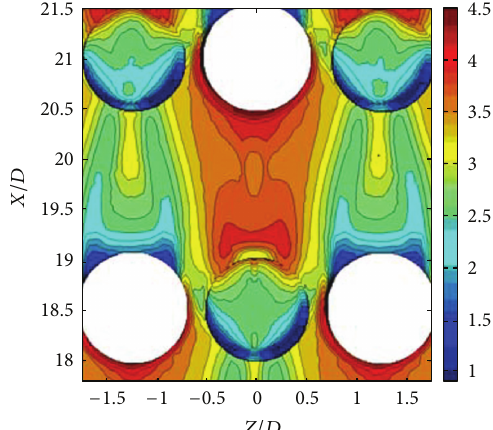
Figure 13: Local Nusselt number ratios on the endwall of the pin fin-dimple channel for Re = 18,600 from the investigation by Rao et al. [5].